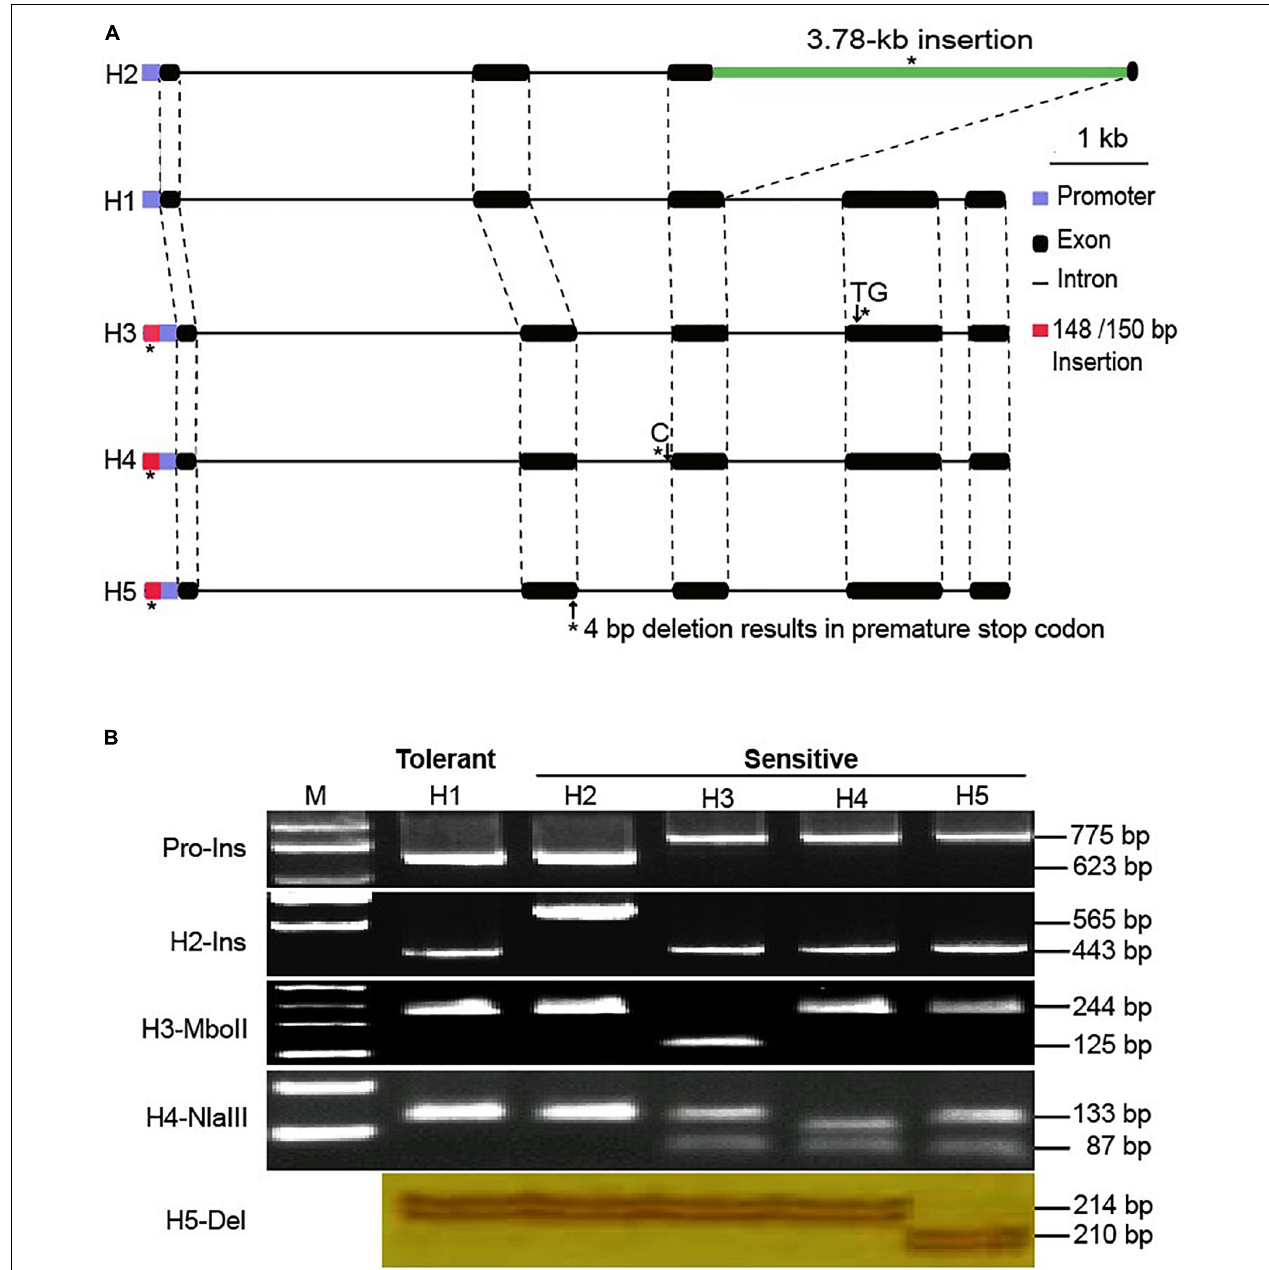
FIGURE 2 | Variation of GmSALT3 and haplotypes (H1–H5) revealed by indel and CAPS markers. Schematic diagrams show the structure of five GmSALT3 haplotypes. Asterisks indicate variations that were used for PCR-based marker development (A) ; Markers that distinguish five haplotypes in soybean varieties (B) .